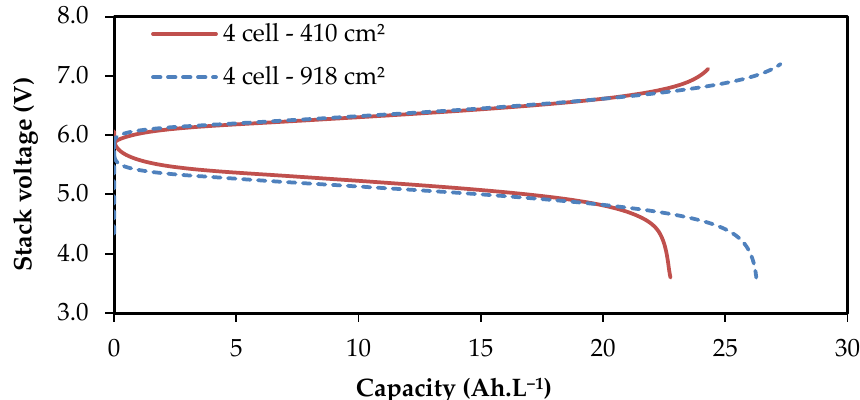
Figure 3. Voltage-capacity curves obtained during charge–discharge cycle test at operating current density of 75 mA.cm −2 , flow rate of 0.37 mL.min −1 .cm −2 on 4-cell stacks made with cells of size 410 cm 2 and 918 cm 2 .